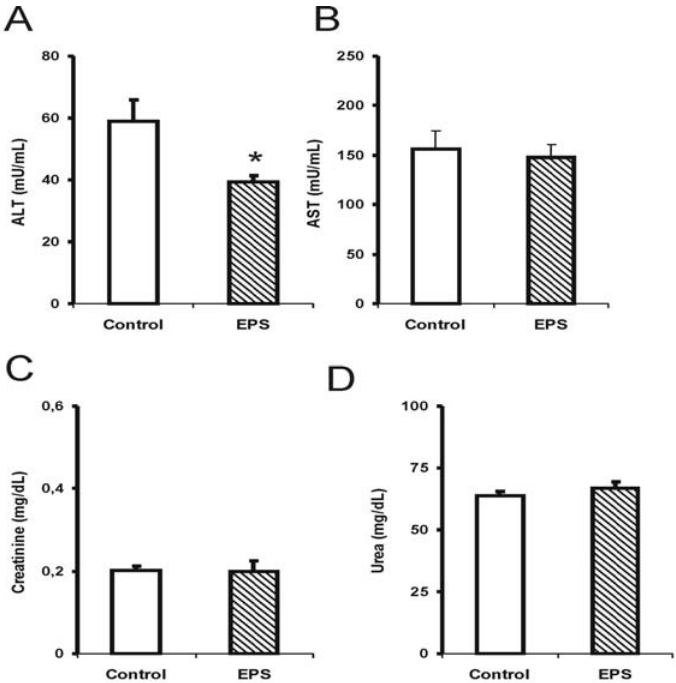
Figure 2. Hepatotoxicity markers in male mice submitted to sub-chronic treatment with lasiodiplodan. Specific transaminases ( A ) ALT and ( B ) AST; ( C ) creatinine, and urea ( D ). ( * ) Values based on p < 0.05.